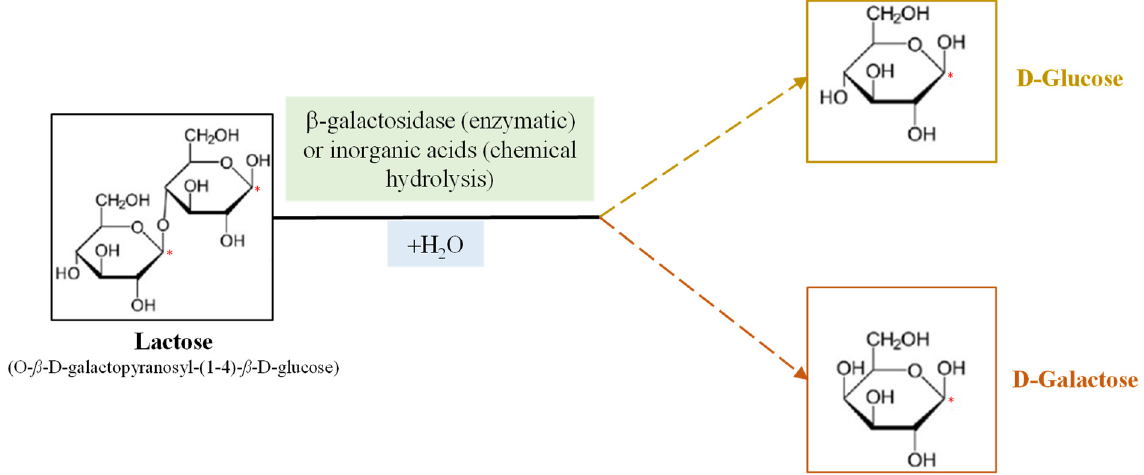
Figure 1. Graphical illustration of lactose hydrolysis. * indicates anomeric groups.